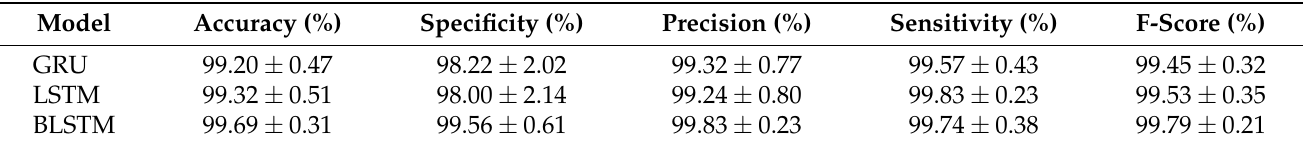
Figure 9. ( a ) Box-plots of the Fp1-channel approximation entropy features obtained for the BMAC and GMAC classes. ( b ) Box-plots of the Fp1-channel sample entropy features obtained for the BMAC and GMAC classes. ( c ) Box-plots of the F7-channel dispersion entropy features obtained for the BMAC and GMAC classes. ( d ) Box-plots of the C4-channel slope entropy features obtained for the BMAC and GMAC classes. ( e ) Box-plots of the O1-channel permutation entropy features obtained for the BMAC and GMAC classes. Table 5. The classification performance obtained using RNN-based classifiers with the hold-out CV approach for the automated classification of the BMAC vs. GMAC task.